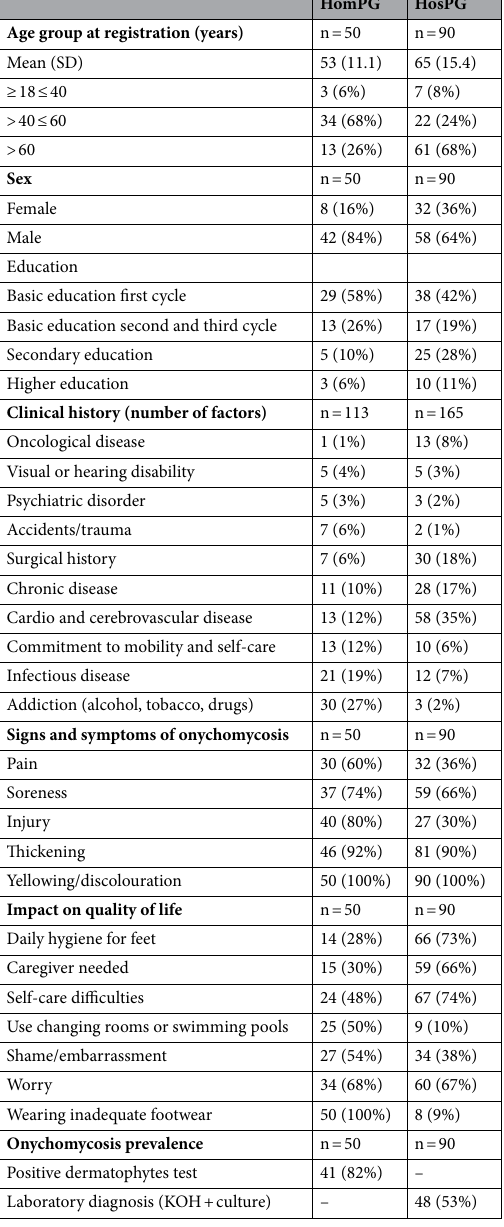
Table 1. Demographic and clinical data of the Homeless People Group (HomPG) and Hospital Patients Group (HosPG). Data are n (%). HomPG Hospital Patients Group, HosPG Homeless People